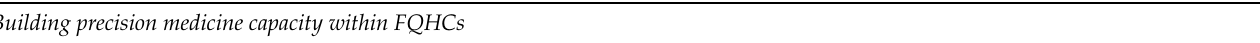
Table 2. Towards sustainable solutions to achieve equitable precision